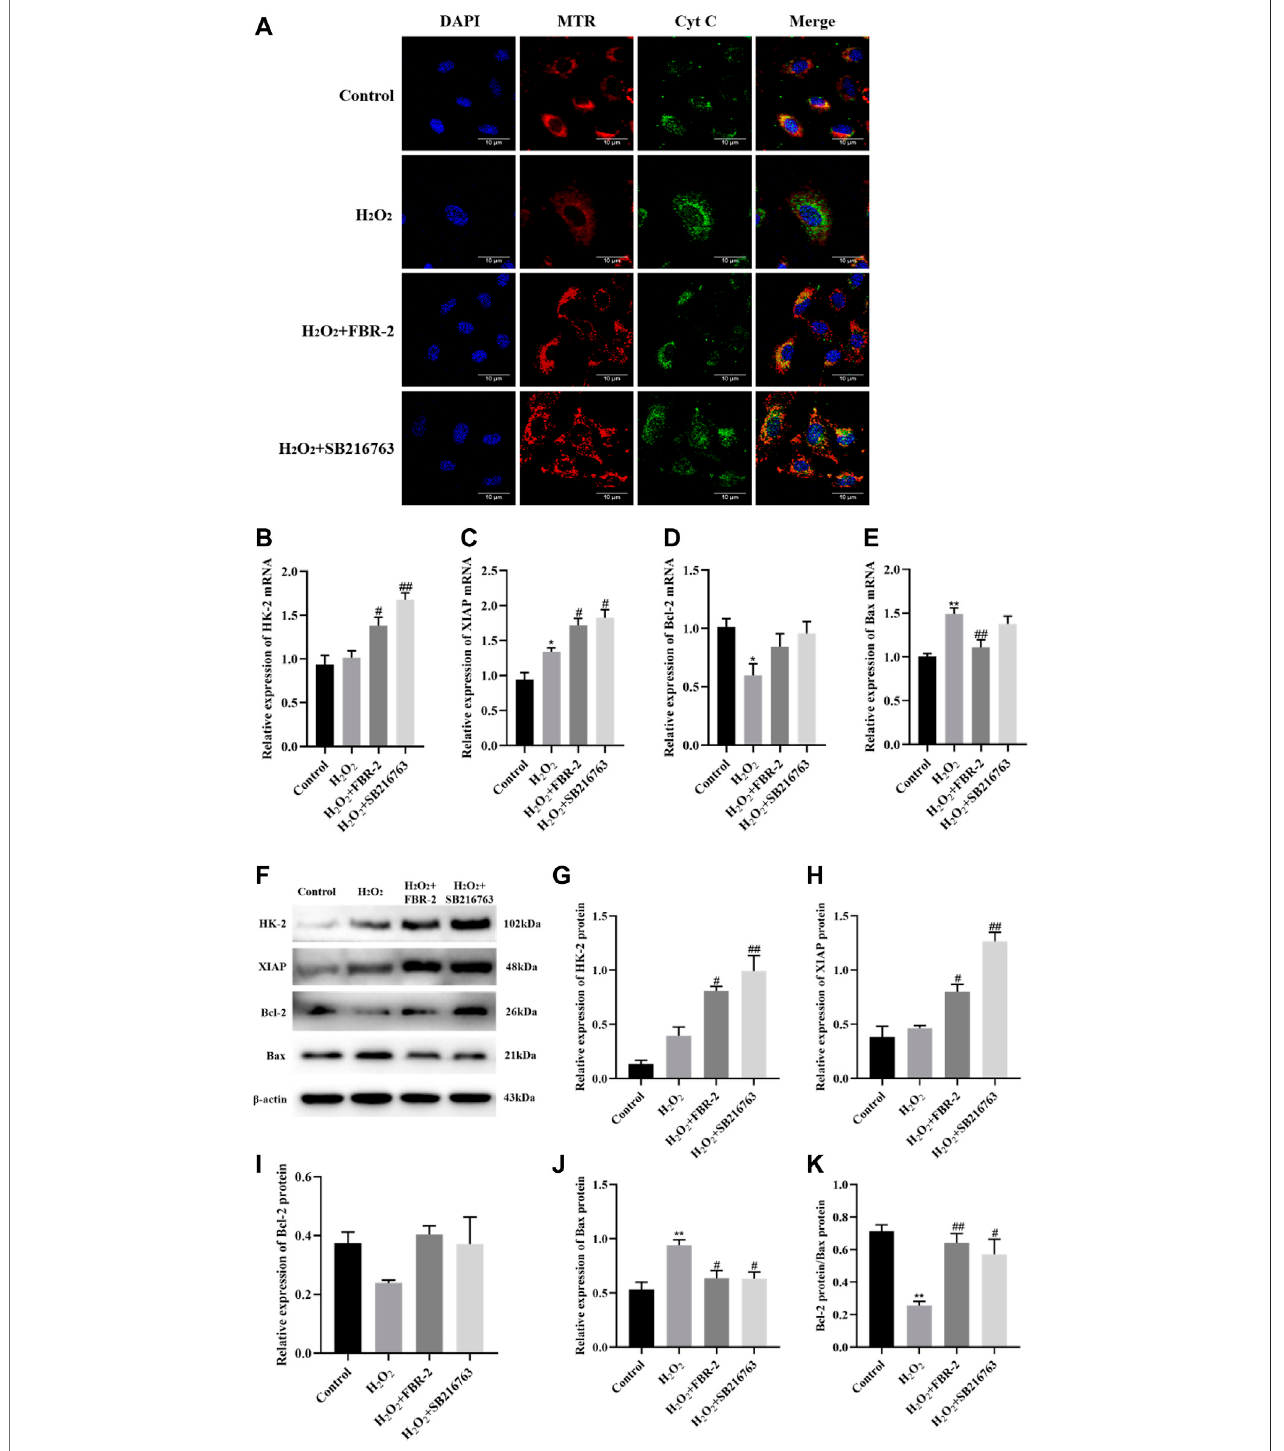
FIGURE 8 | FBR-2 inhibits cell apoptosis. (A) Immuno fl uorescence colocalization between mitochondria (MTR) and Cyt C. (B) HK-2 mRNA levels ( n = 6). (C) XIAP mRNA levels ( n = 6). (D) Bcl-2 mRNA levels ( n = 6). (E) Bax mRNA levels ( n = 6). (F) The blots of HK-2, XIAP, Bcl-2, Bax and β -actin. (G) HK-2 protein levels ( n = 3). (H) XIAP protein levels (n = 3). (I) Bcl-2 protein levels ( n = 3). (J) Bax protein levels ( n = 3). (K) The ratio of Bcl-2/Bax. * p < 0.05 and ** p < 0.01, compared with the control group; # p < 0.05 and ## p < 0.01, compared with the H 2 O 2 group.